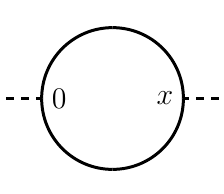
Figure 3 . The vacuum polarization diagram for the (cid:27) (cid:12)eld. Dashed lines correspond to the (cid:27) (cid:12)eld, and solid lines correspond to the (cid:30)